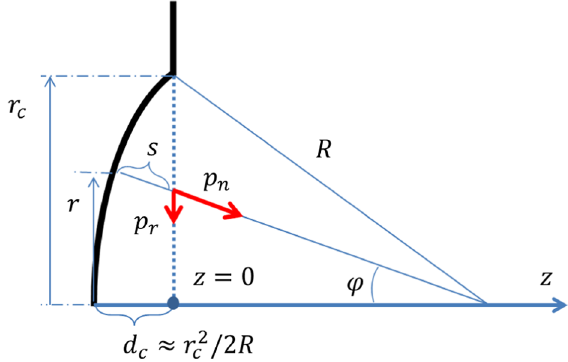
FIG. 18. Beam optics in the vicinity of a concave cathode.